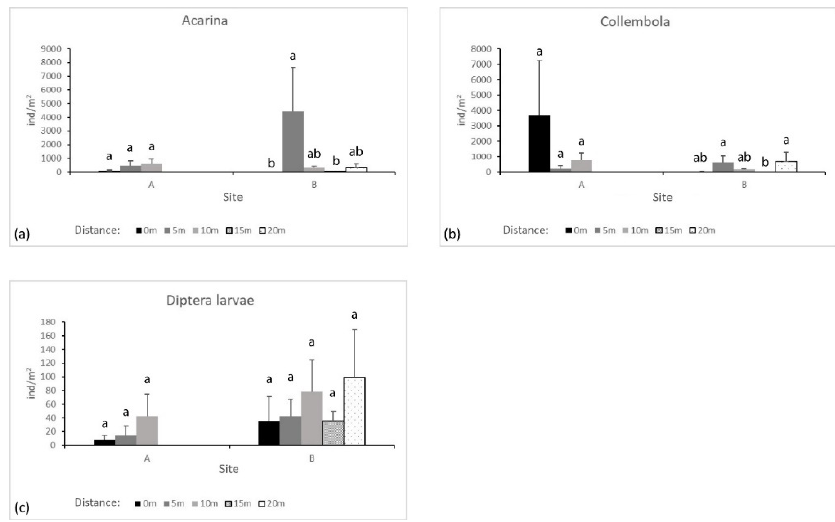
Figure 8. Average and Standard Error of groups accounting for at least 90% of total arthropod abundance. ( a ) Acarina abundance per m²; ( b ) Collembola abundance per m²; ( c ) Diptera larvae abundance per m². Different letters above bars mean significant differences within transects ( p ≤ 0.01).